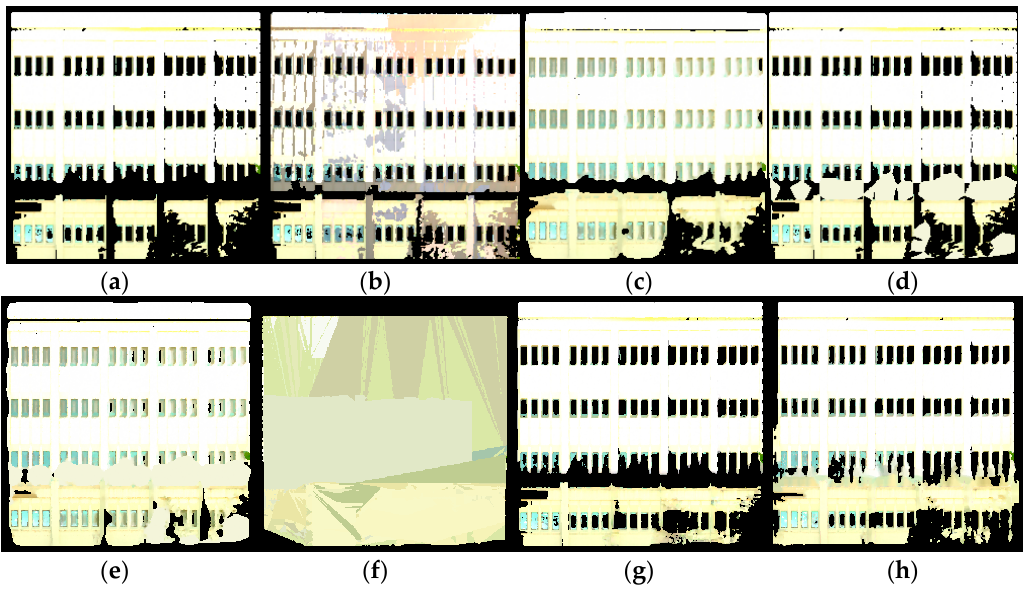
Figure 9. Point cloud scene completion results for the Mason building, visualized in 2D: ( a ) input point cloud, ( b ) target ground truth, ( c ) Poisson reconstruction, ( d ) hole-filling, ( e ) hybrid, ( f ) plane-fitting, ( g ) partial convolution, and ( h ) proposed.